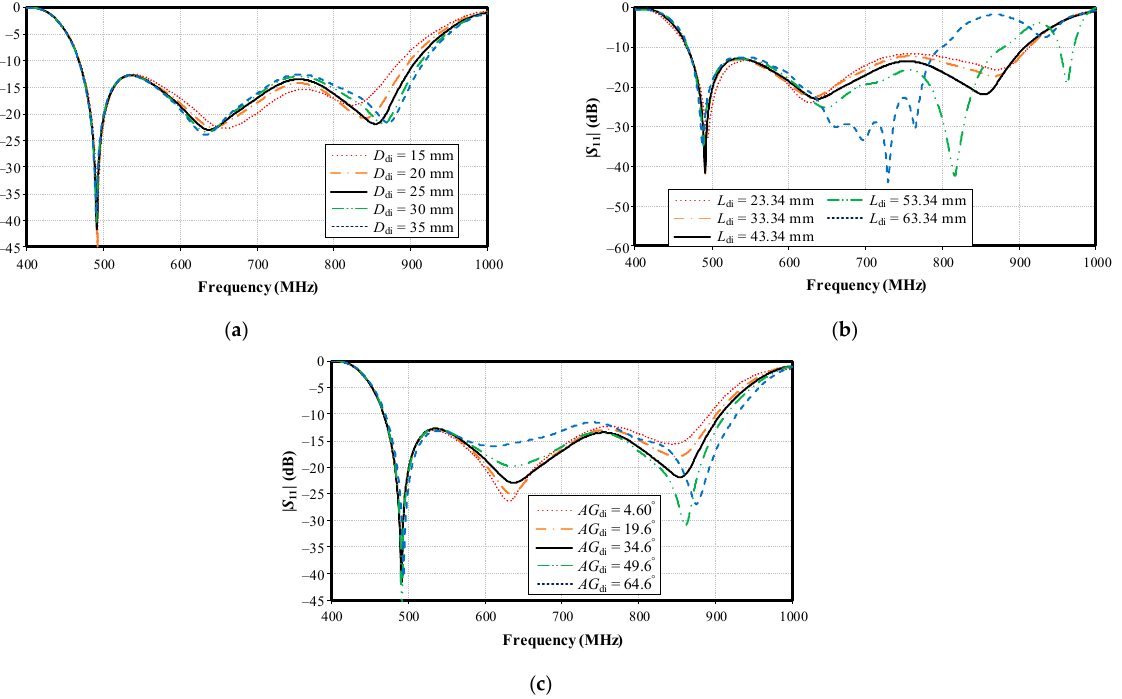
Figure 14. Simulated impedance bandwidth (| S 11 | ≤ − 10 dB) under variable parameters: ( a ) distance between the director and center of the supporting plate ( D di ), ( b ) director’s arm length ( L di ), and ( c ) angle of the director’s arm ( AG di ).